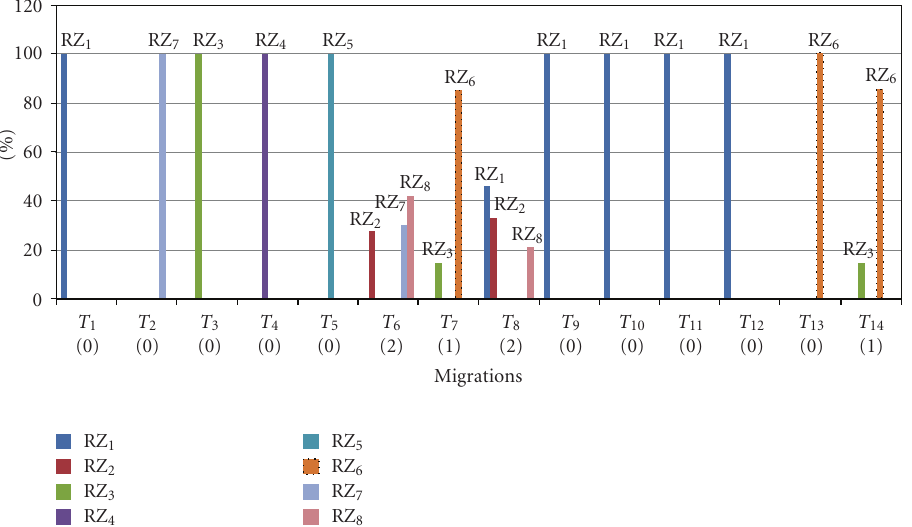
Figure 11: Task Occupation rates on RZs after task